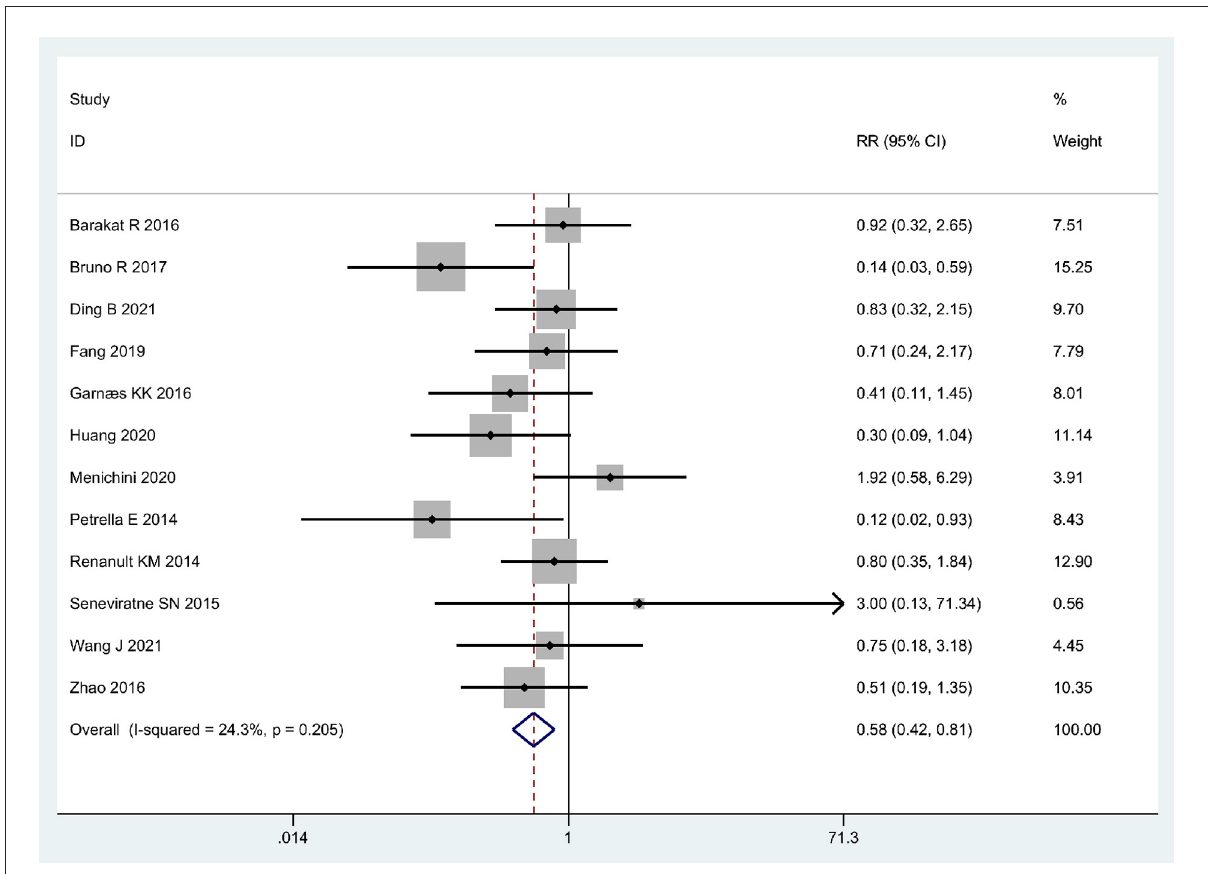
FIGURE2 Forrest plot: Association between physical exercise and the risk of GH in obese and overweight pregnant women.